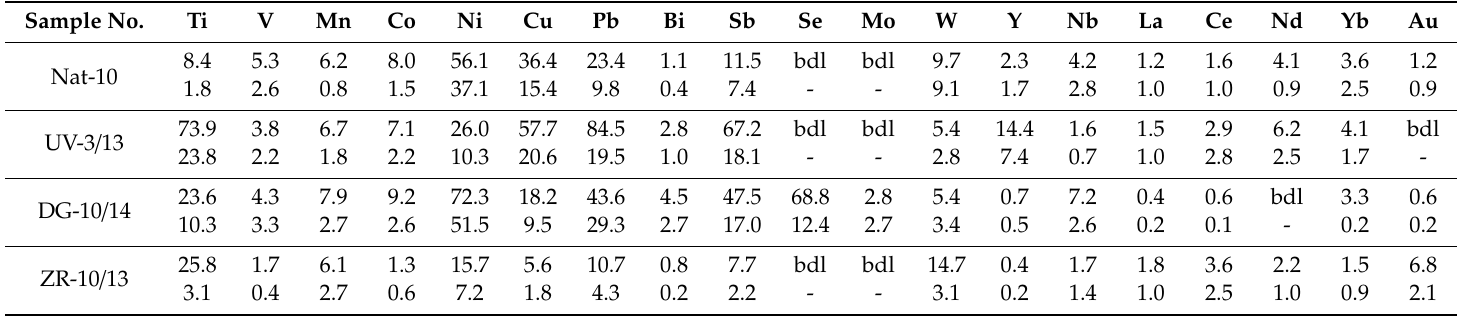
Table 5. Refined LA-ICP-MS data (in ppm) for pyrite coexisting with arsenopyrite at the orogenic gold deposits located in north-eastern Russia (Magadan Region). Sample No.